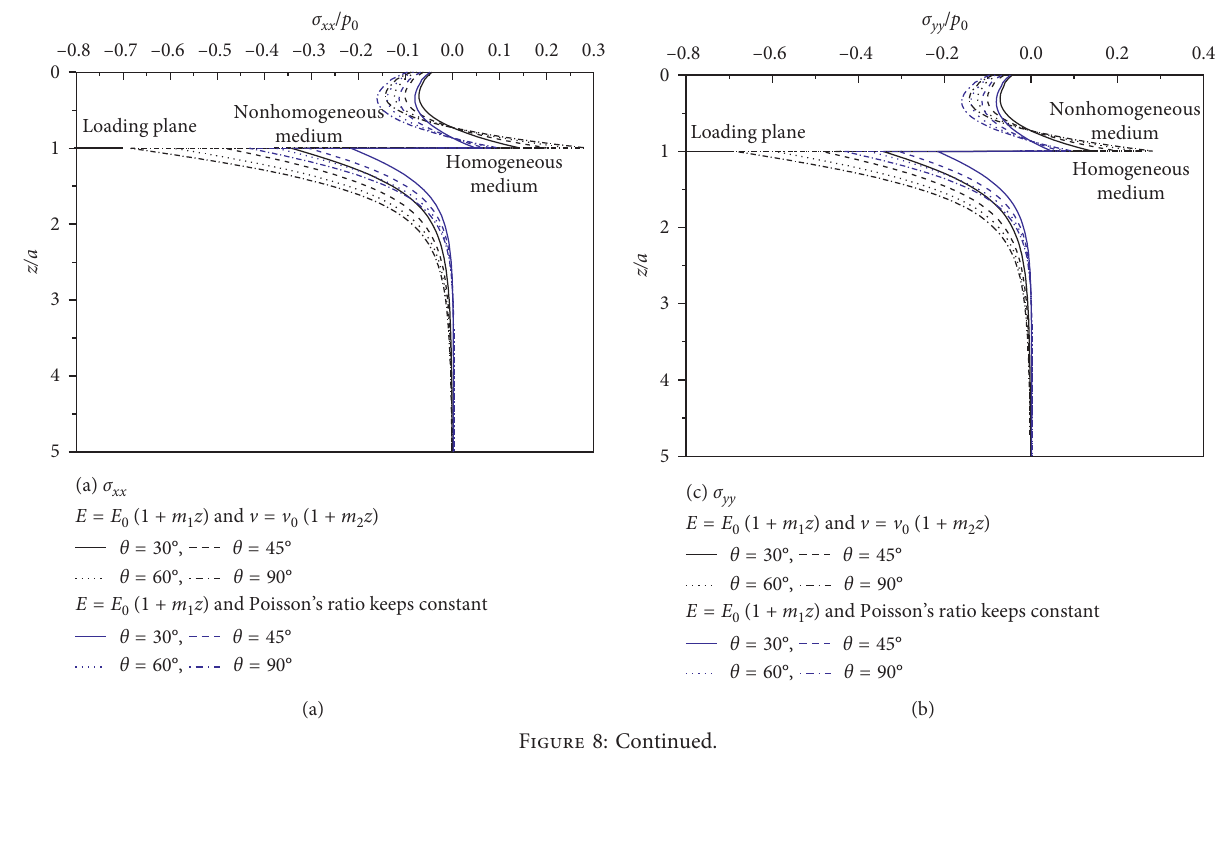
� a and h � a for different θ . (a) u x and u z for d